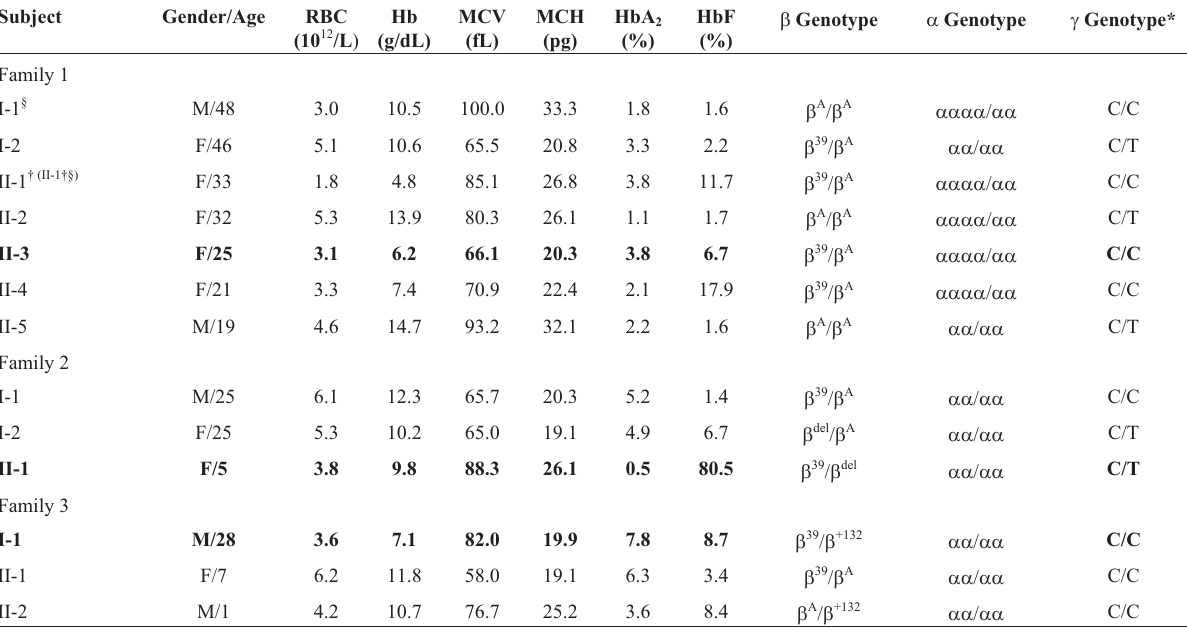
Table 1 - Hematological, biochemical and molecular data of three Mexican families with (cid:2) -thal